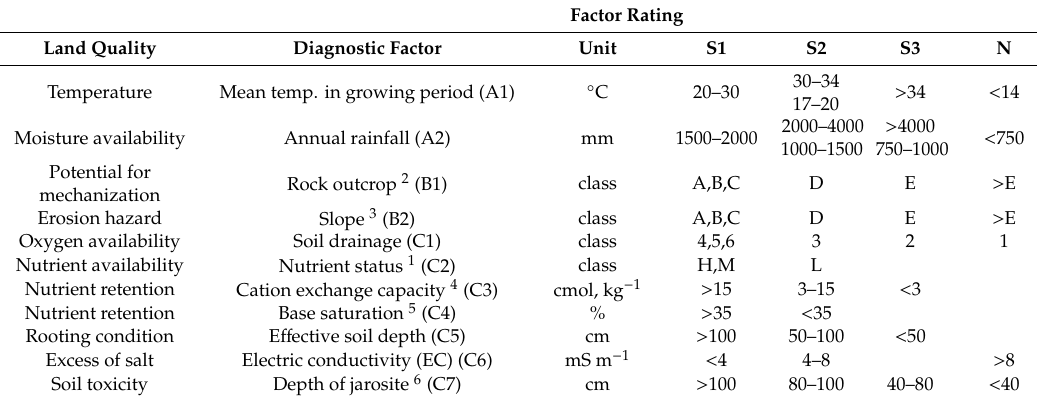
Table 2. Diagnostic factors for eucalyptus suitability